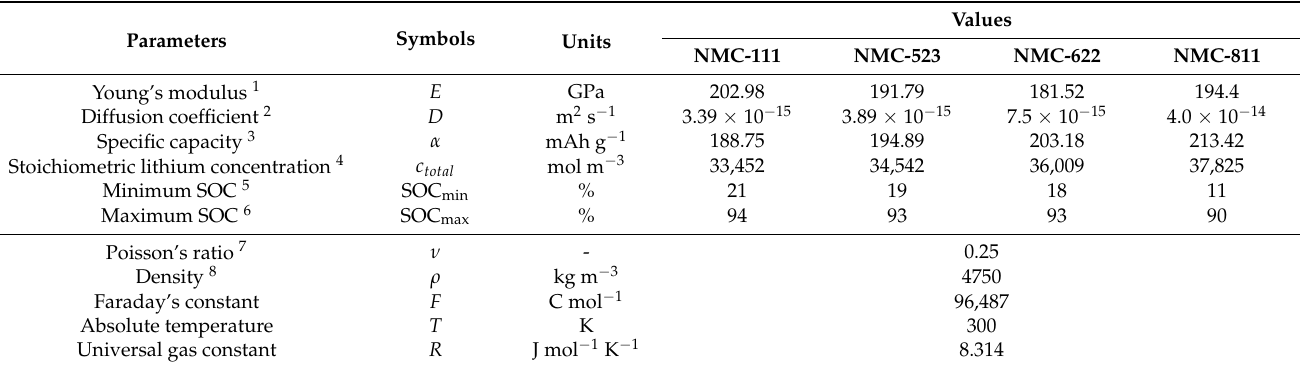
Table 1. Summary of simulation parameters and material properties for NMC materials used for numerical simulations.